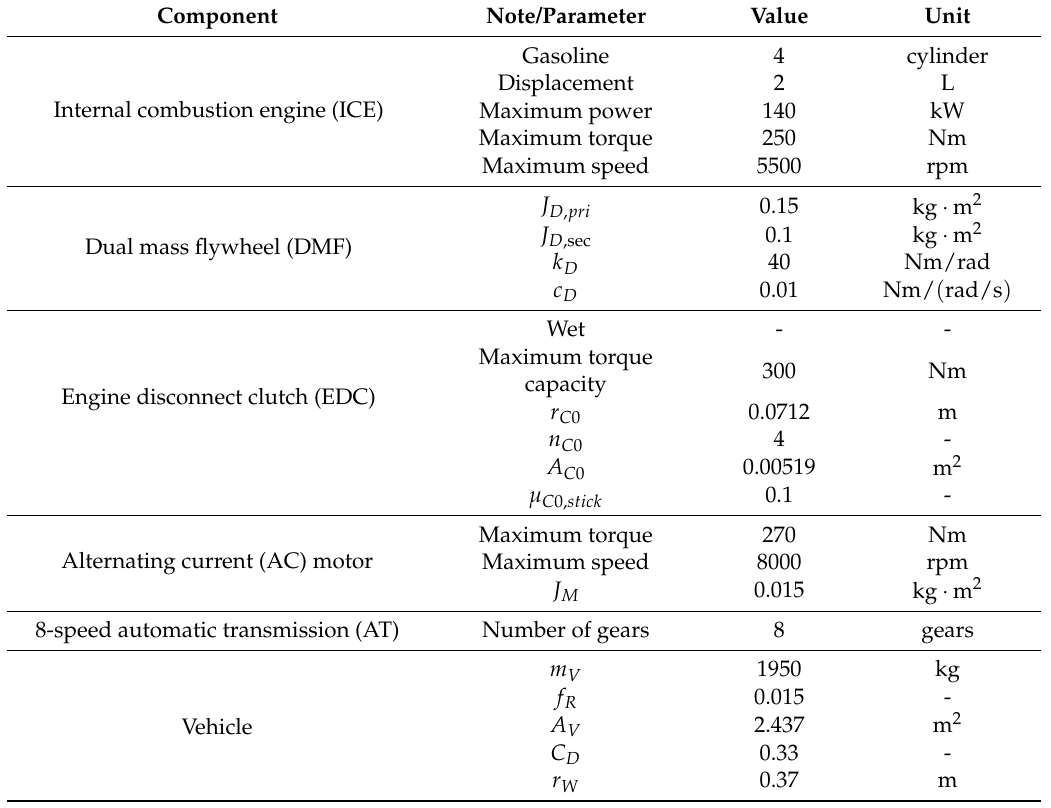
Table 1. Main parameters of the P2 hybrid system model.